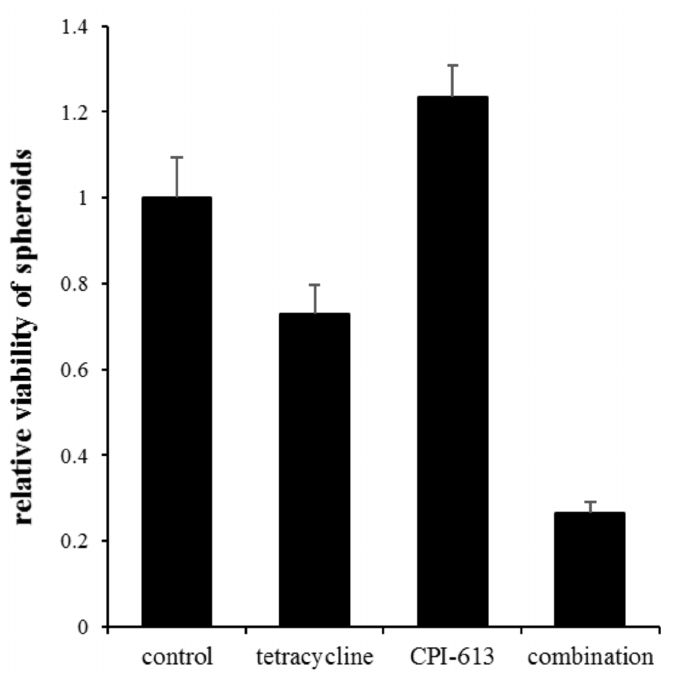
Figure A9. The effect of CPI-613 and tetracycline on the viability of spheroids. Viability of PaTu- 8902 cells cultured in the form of spheroids for 2 weeks in the presence of 1% dimethyl sulfoxide as a vehicle (control), 50 µ M tetracycline, 50 µ M CPI-613, or both. Viability was measured by resazurin